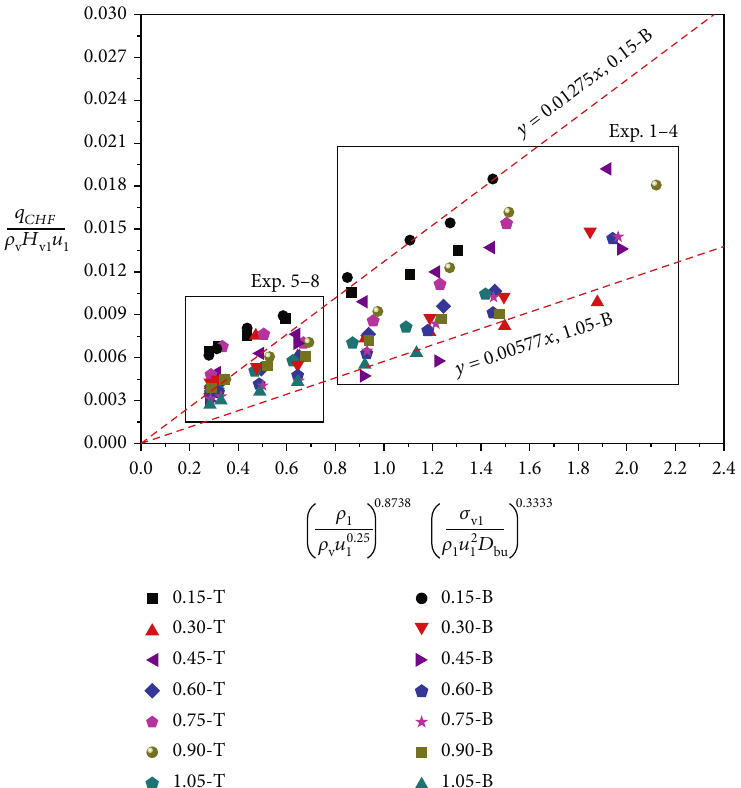
Figure 23: Correlation on q